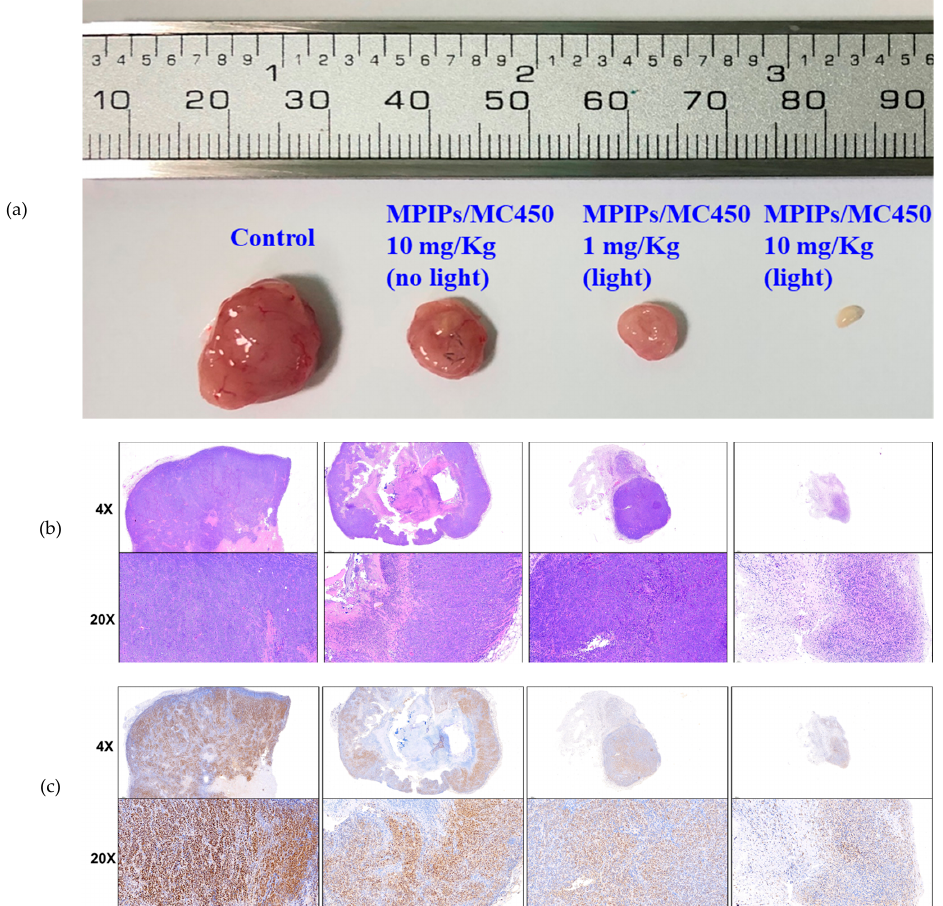
Figure 6. ( a ) Pictures of tumor specimens from the xenograft models with treatment of PBS (control), 10.0, 1.0 and 10.0 mg/kg of MPIPs/MC540; the latter two groups were irradiated with 15 min of an LED mini dot light 1 h after injection. ( b ) Hematoxylin & eosin (HE) staining of above tumor specimens. ( c ) Immunohistochemical (IHC) staining with anti-proliferating cell nuclear antigen (PCNA) primary antibodies.